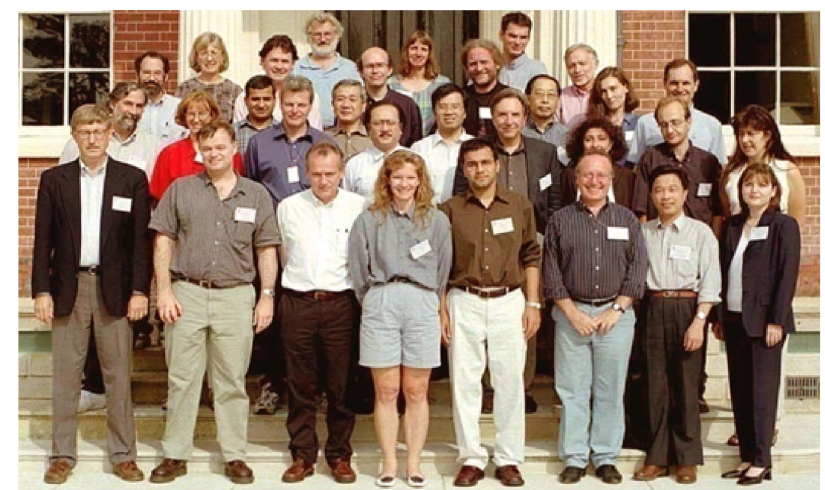
Figure 1. The International Human Genome Sequencing Consortium at the 5th Strategic Meeting, Aug. 31, 1999, Hinxton,